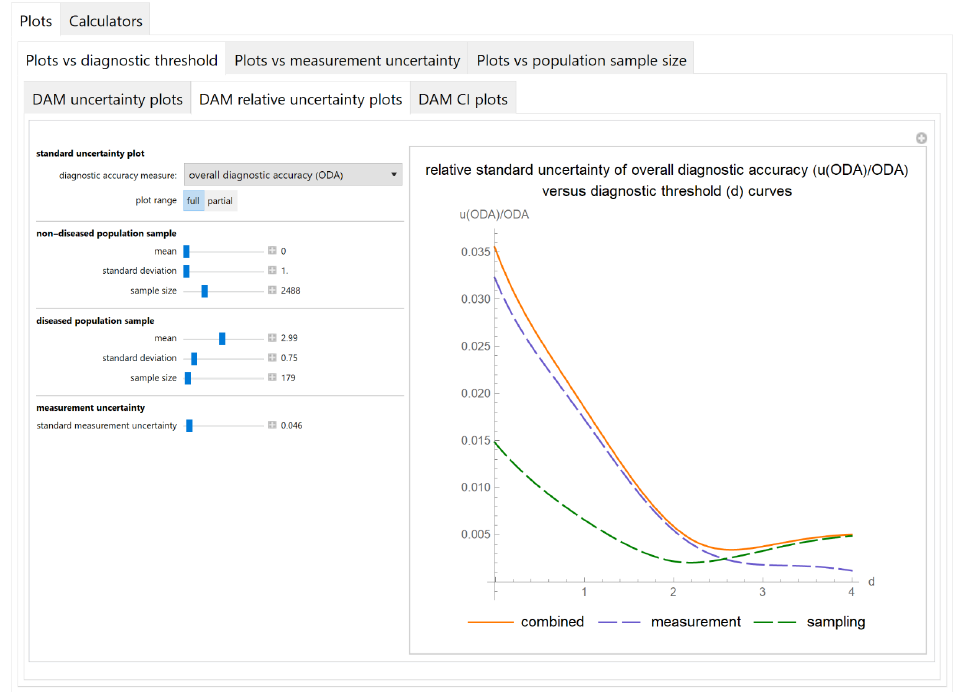
Figure 4. Plots vs. diagnostic threshold module, DAM relative uncertainty plots submodule screenshot. Relative standard combined, measurement and sampling uncertainty of overall diagnostic accuracy ( u(ODA)/ODA ) versus diagnostic threshold ( d ) curve plot, with the settings shown on the left. The respective parameter settings are also shown in Table 3.